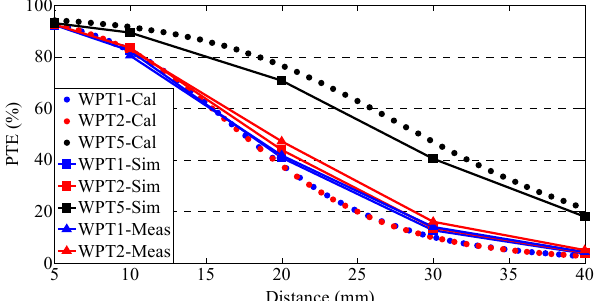
Figure 6. E ff ect of coils relative distance on the power transfer e ffi ciency. The terms “-cal”, “-sim” and Figure 6. Effect of coils relative distance on the power transfer efficiency. The terms “-cal,” “-sim” and “-meas” refer to the calculation, simulation and measurement “-meas” refer to the calculation, simulation and measurement results.